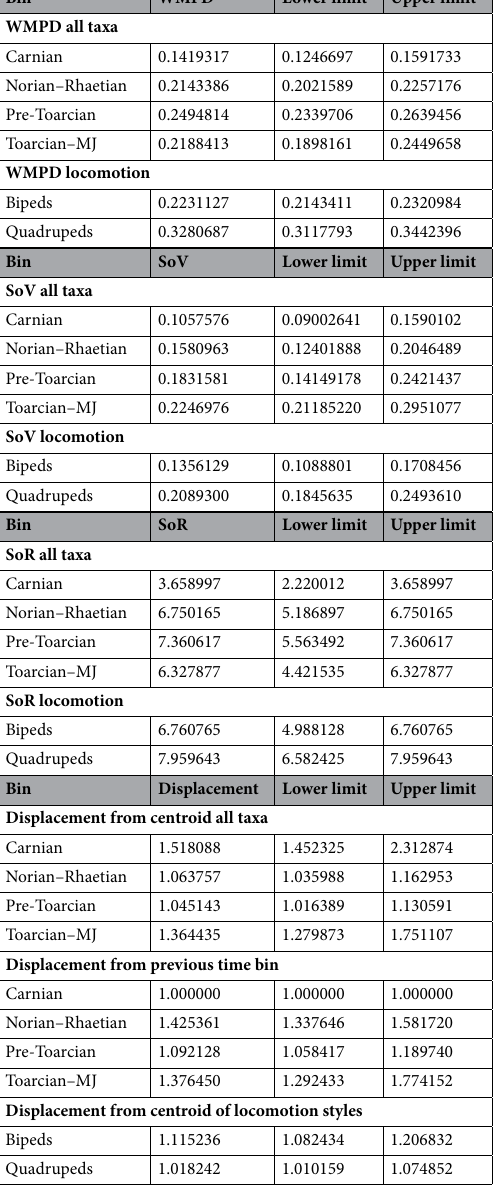
Table 1. Selected results of the morphological disparity analyses (all other results are reported in the supplementary information). The upper and lower limits were calculated after building 95% confidence intervals calculated from 9999 bootstrap replicates of the distance (WMPD) and ordinated matrices (other measures). Abbreviations: MJ, Middle